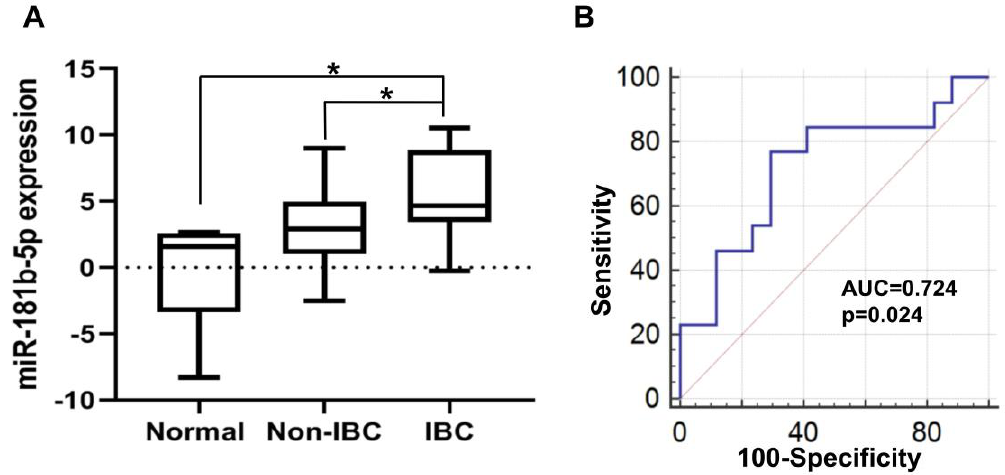
Figure 3. Expression and diagnostic value of miR-181b-5p in carcinoma tissues of non-IBC and IBC in comparison with normal breast tissue samples. ( A ) miR-181b-5p expression level is significantly elevated in carcinoma tissues of IBC ( n = 13) relative to normal tissues ( n = 5) and non-IBC ( n = 17) as determined by qPCR. miR-181b-5p expression is log2-transformed and normalized to values of normal breast tissues collected during reduction mammoplasty. * p < 0.05 as determined by Mann-Whitney U-test. ( B ) Receiver operating characteristic (ROC) curve generated using expression levels of miR-181b-5p to discriminate between patients with non-IBC and IBC.